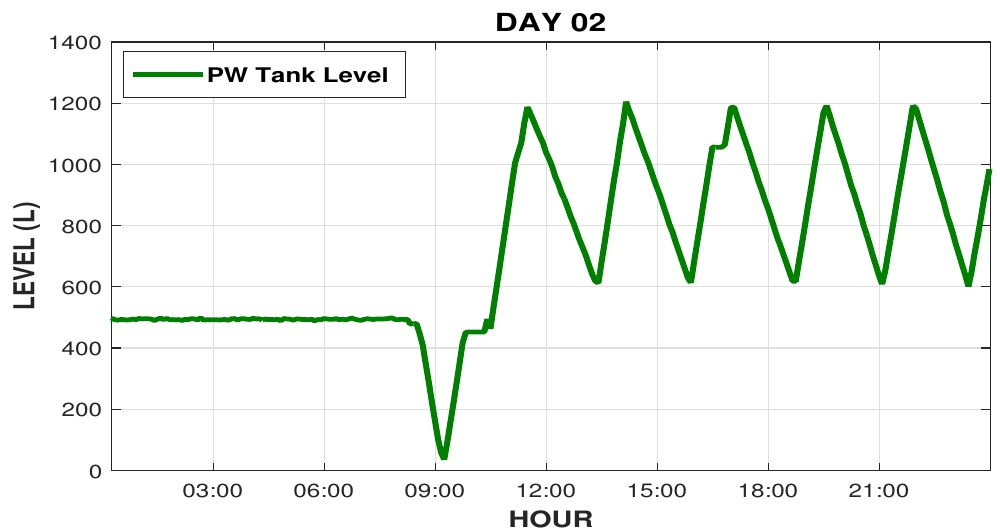
Figure 18. Readings of the PW tank level on the second intervention day.